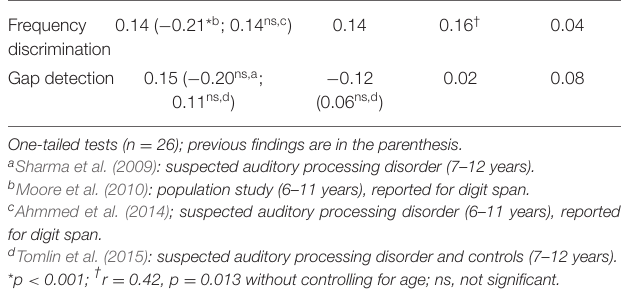
TABLE 1 | Partial correlations between auditory and working memory measures. Forward digit